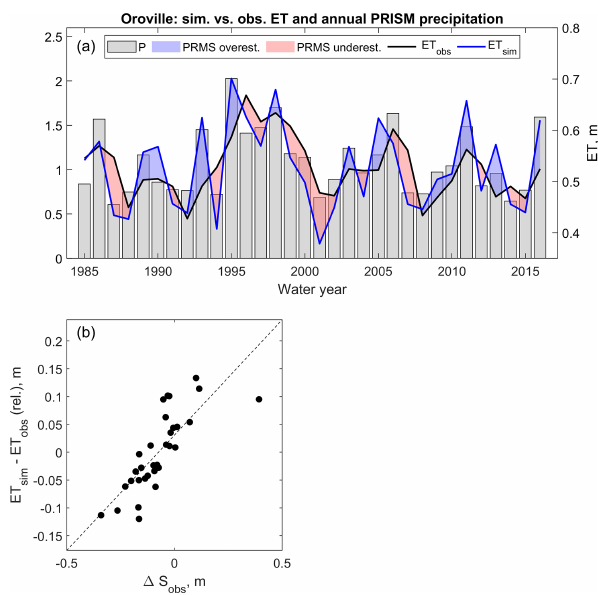
Figure 10. (a) Simulated and estimated annual basin-wide evapo- transpiration for the Feather River at Oroville (lines) and annual pre- cipitation according to PRISM (bar chart). (b) Annual differences between simulated and estimated basin-wide evapotranspiration as a function of estimated change in subsurface water storage. The absolute value of the systematic bias between simulated and ob- served basin-wide evapotranspiration ( ∼ 110mm; see Fig. 7) was subtracted from observed values for readability. Simulated annual evapotranspiration includes the groundwater-sink mass-flux com- ponent (see Sect.